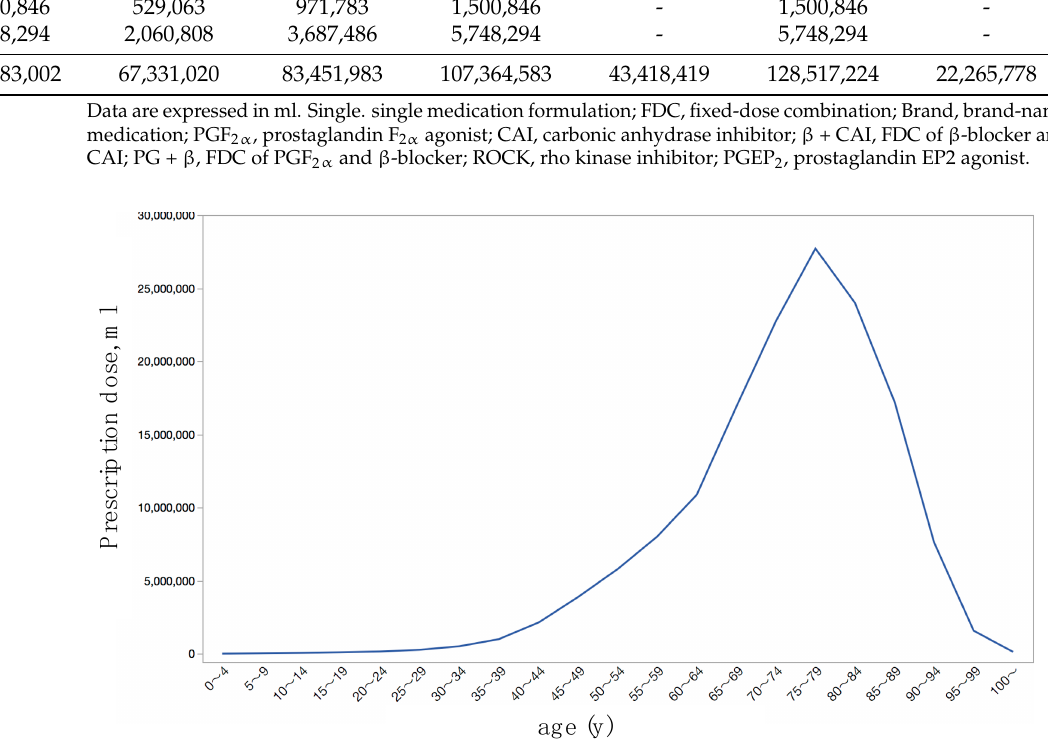
Figure 1. Age-dependent distributions of prescription dose of topical anti-glaucoma medications.